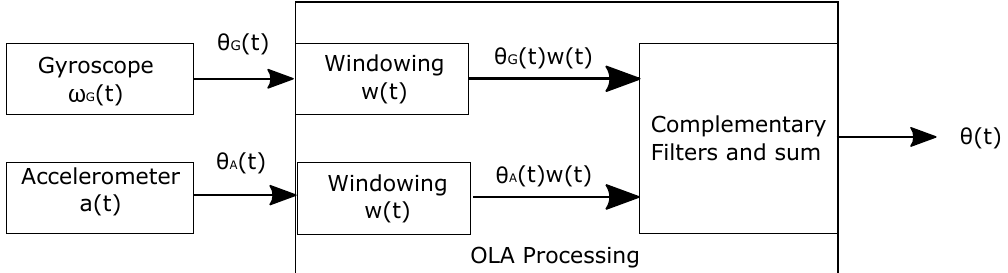
Figure 3. Schematic representation of signal processing method programmed